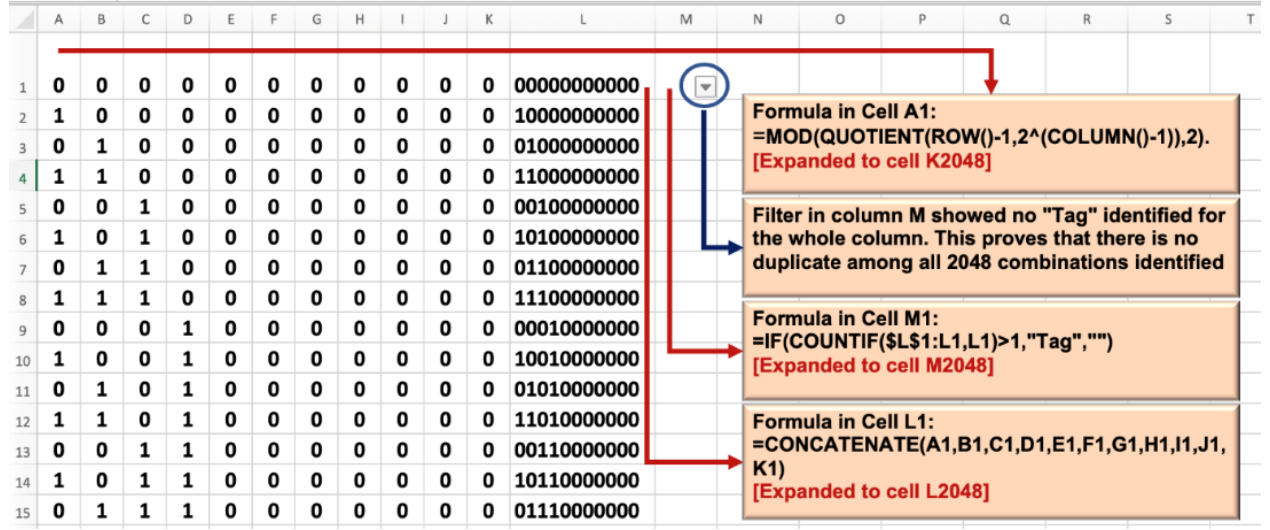
Figure 2. Determining and proving 2048 unique combinations of 11 predictors .